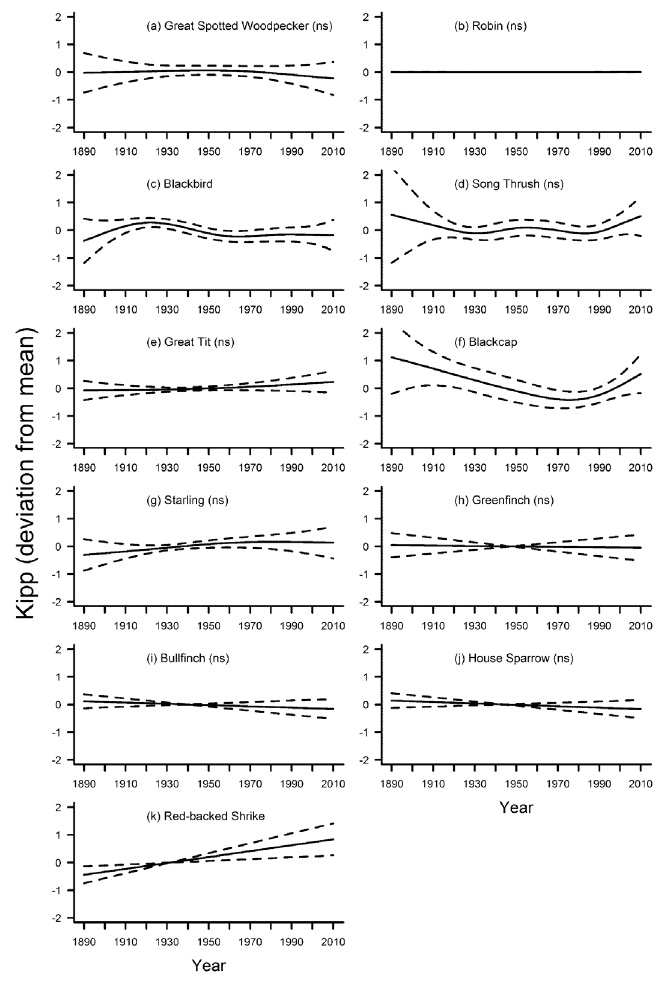
Figure 6. Fluctuations in wing pointedness (Kipp) of eleven bird species in southern Germany between 1889 and 2010. Solid line – regression spline fit from the GAM; dashed lines – 95% confidence intervals. See methods for details. A p-value of . 0.05 is indicated with (ns) after the species name, see table 2 for exact p-values.